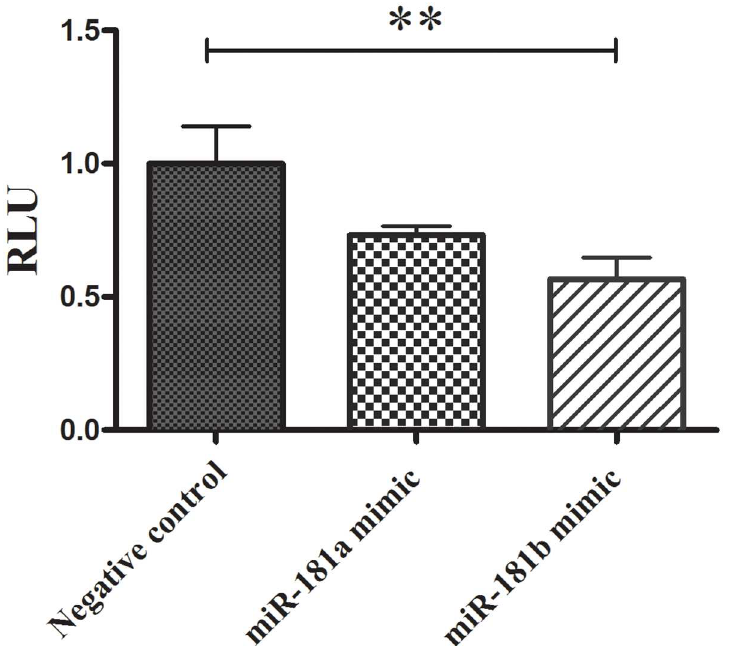
Fig 2. DENN/MADD is a target gene for miR-181b. Luciferase assay confirms the interaction of miR-181b with DENN/MADD transcript. Co-transfection of HEK293T cells with vectors encoding the 3’UTR of DENN/ MADD ligated to the Renillaluciferasewith microRNAmimic sequencesand negative control sequence showedsignificantdecreaseof luciferase activity in cells transfected with miR-181b mimic sequences. Renillaluciferase levels were normalizedagainstinternalFirefly luciferase. Data are shown as means ± SEM ( n = 5). ANOVA, Tukey post hoc ( ** p (cid:20) 0.01 relative to negativecontrol)